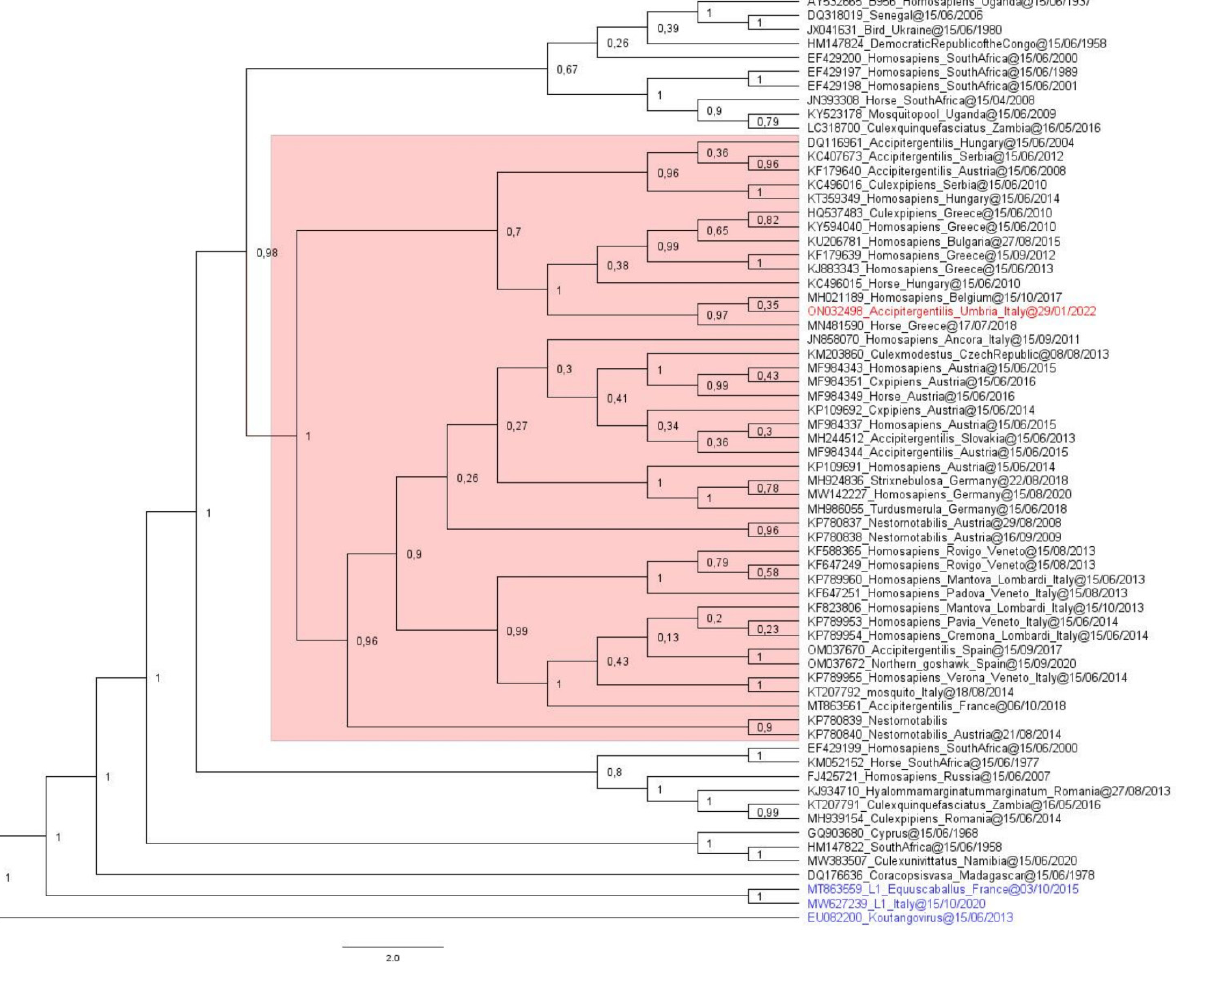
Figure 2. The evolutionary analysis inferred by using the maximum-likelihood method and the general time reversible model is illustrated. The tree with the highest log-likelihood is shown. The percentage of trees in which the associated taxa clustered together is displayed next to the branches. Initial trees for the heuristic search were obtained by applying the neighbor-joining method to a matrix of pairwise distances estimated using the maximum composite likelihood (MCL) approach. A discrete Gamma distribution was used to model evolutionary rate differences among the sites (4 categories). The evolutionary distances were computed using the optimal GTR + Γ + I model, with 2000 Γ -rate categories and 5000 bootstrap replications using the Shimodaira–Hasegawa (SH) test. Ten independent MCMC runs with up to 100 million generations were performed to ensure the convergence of the estimates. GenBank accession numbers are indicated for each strain, with country, lineage, and year of isolation. The genome sequence ON032498 WNV L2 (HCov 91%), obtained from the goshawk organ homogenate, is highlighted in red. The WNV L1 MW627239 (Italy 2020) and MT863559 (France 2015), and Koutango virus (KOUTV) EU082200 (Senegal 2013), chosen as outgroups, are highlighted in blue. The new strain (ON032498) showed high genetic similarity with the central-southern European WNV L2 clade, highlighted in pink, with a posterior probability of 100%. 4. Discussion This study reported the second evidence of WNV L2 circulation in the Umbria region. The current National Surveillance Plan includes Umbria amongst those areas whose eco- climatic characteristics are favorable for viral circulation but where WNV has never or sporadically circulated in the past (National Plan for Prevention, Surveillance, and Response to Arbovirus 2020–2025). In fact, no WNV circulation has ever been reported in the territory, neither in humans [31] nor in animals, before 2019, when the virus was